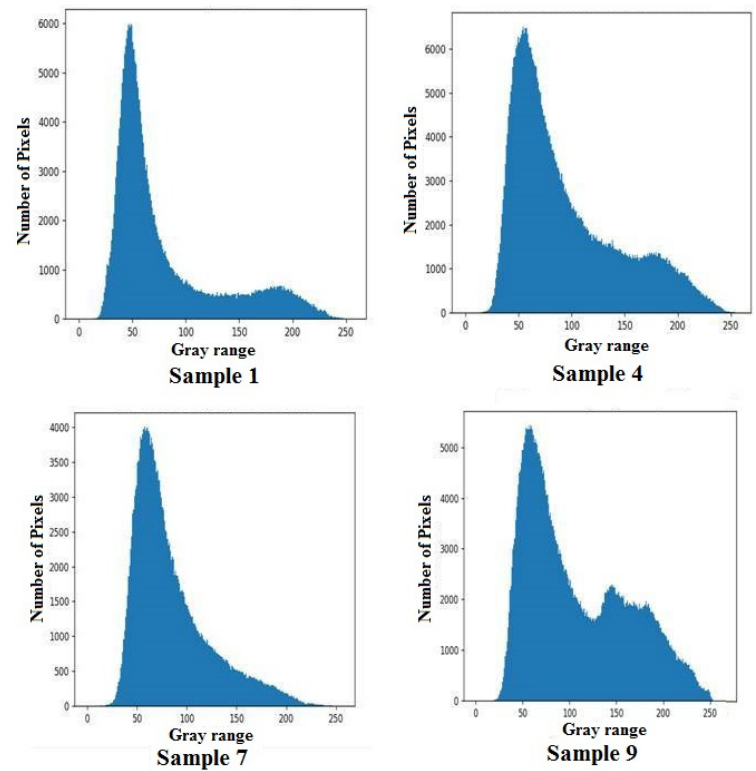
Figure 5. Histogram plot for buffalo leather samples.